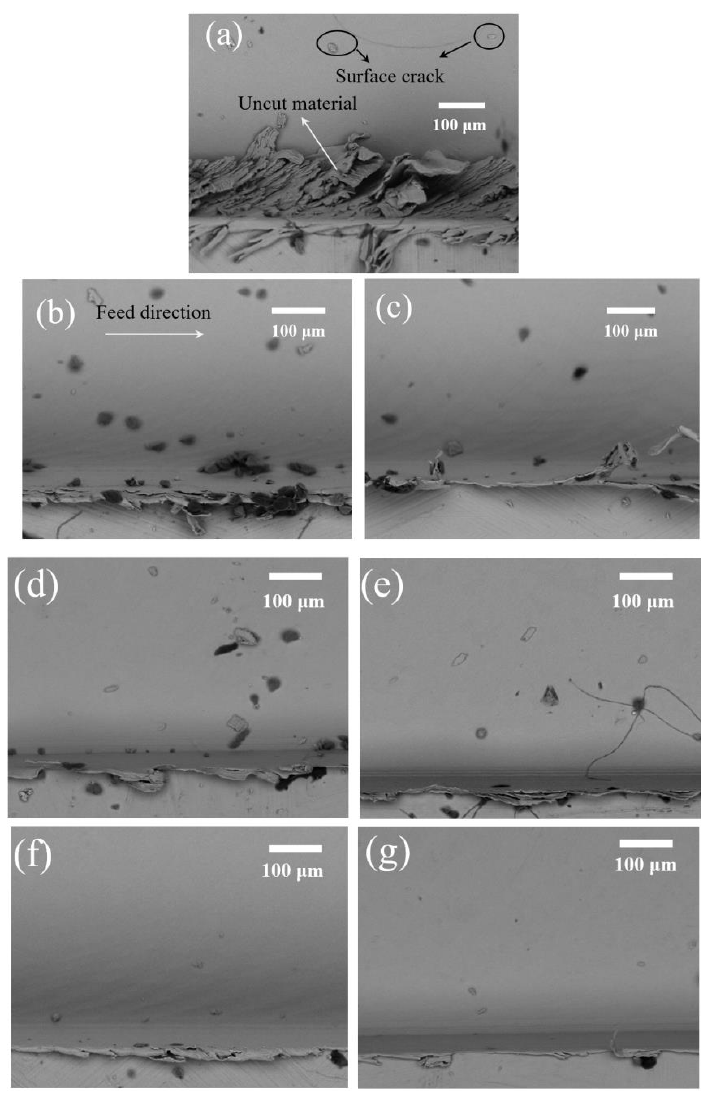
Figure 14. SEM measurement of burrs and the machined surface at the edge area of the up milling side of conventional micro milling and vibration-assisted micro milling at the cutting length of 600 mm. ( a ) Conventional micro milling; ( b ) a vibration amplitude of 0.5 µm and a vibration frequency of 1500 Hz; ( c ) a vibration amplitude of 1µm and a vibration frequency of 1500 Hz; ( d ) a vibration amplitude of 0.5 µm and a vibration frequency of 3500 Hz; ( e ) a vibration amplitude of 1 µm and a vibration frequency of 3500 Hz; ( f ) a vibration amplitude of 0.5 µm and a vibration frequency of 5500 Hz; ( g ) a vibration amplitude of 1 µm and a vibration frequency of 5500 Hz.